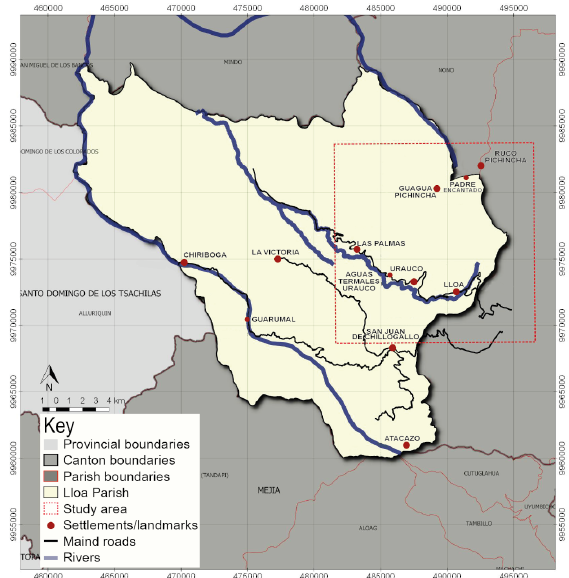
Figure 2: Main road